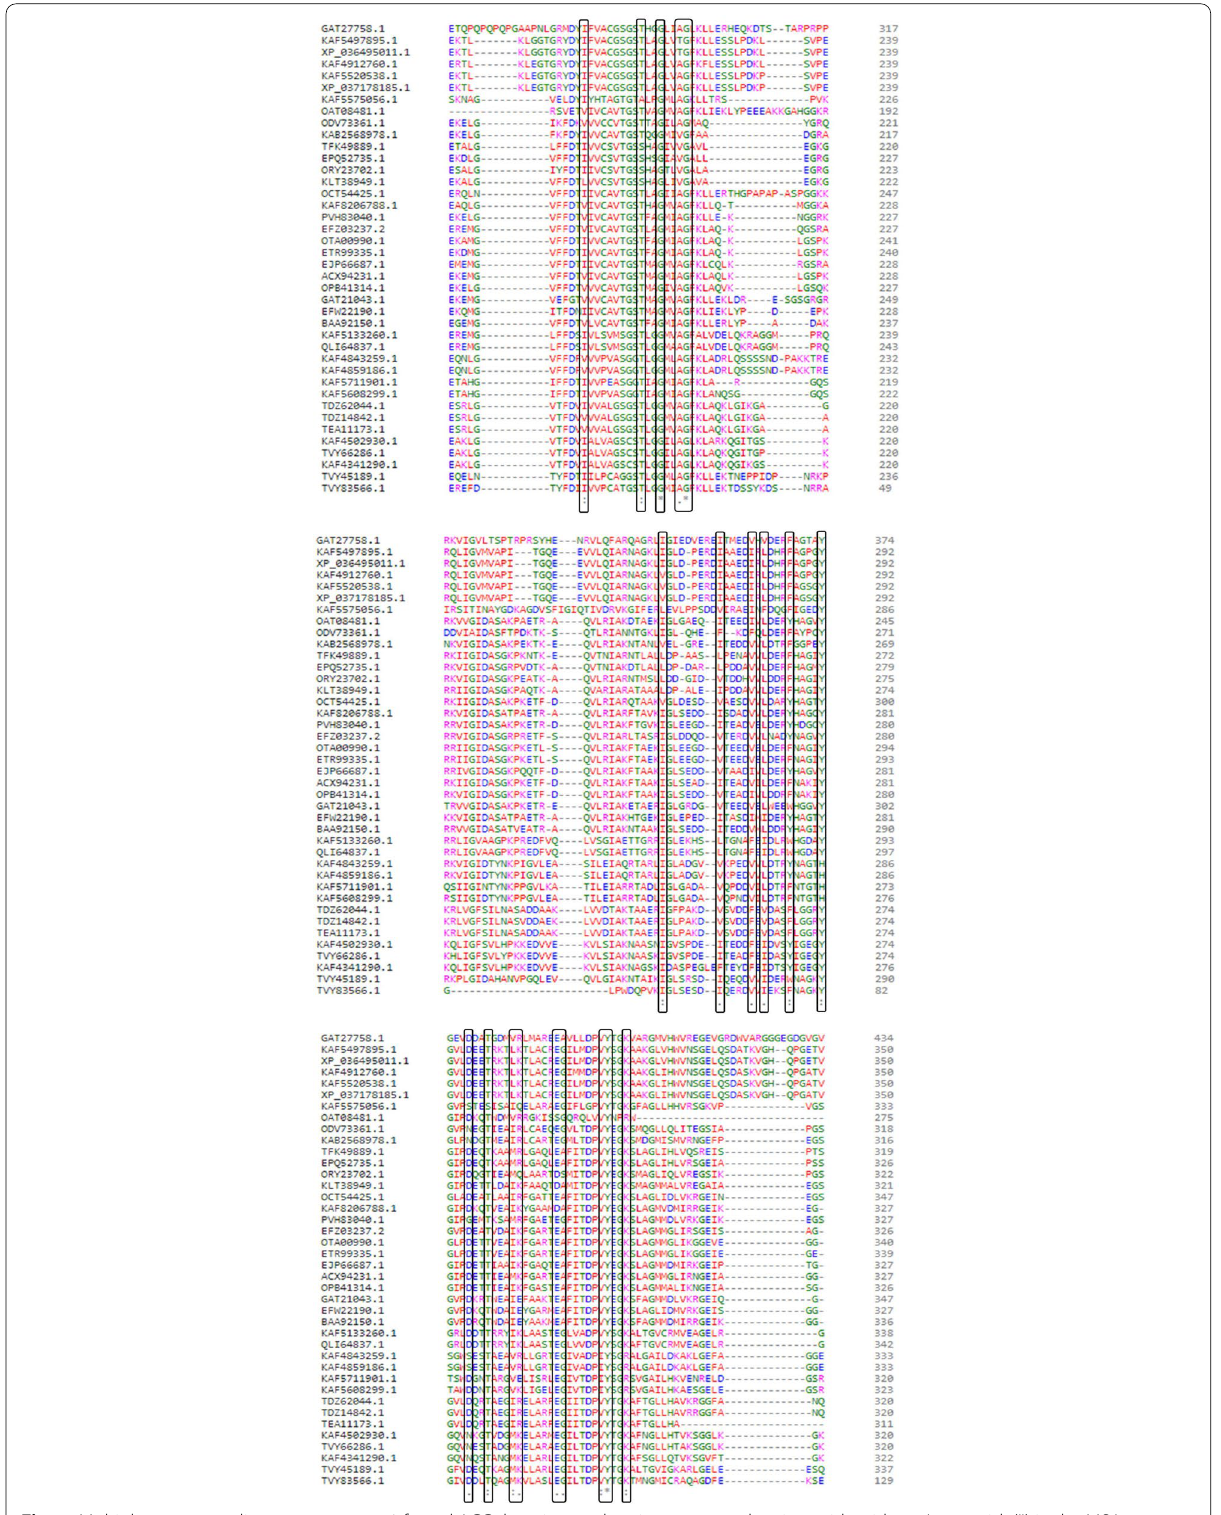
Fig. 5 Multiple sequence alignment among 40 fungal ACC deaminases showing conserved amino acid residues. An asterisk (*) in the MSA specified fully conserved residue while a colon (:) indicated conservation between groups of strongly similar properties and a period (.) is the sign of conservation between groups of weakly similar